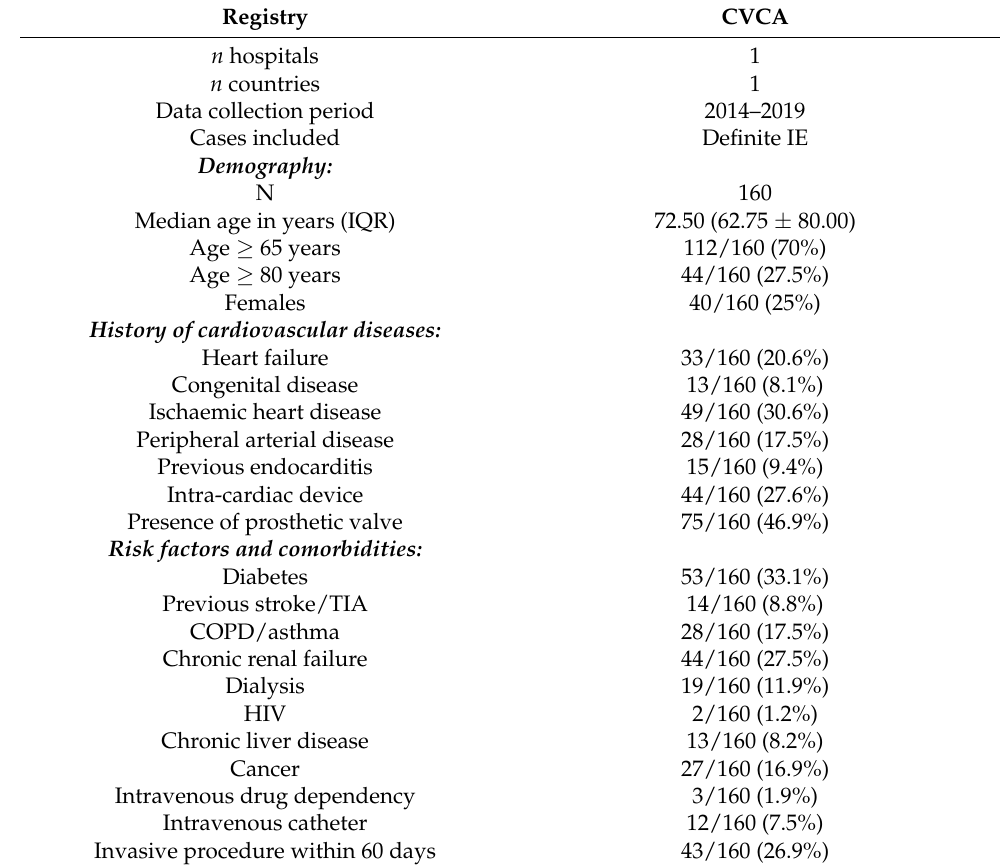
Table 1. Patient